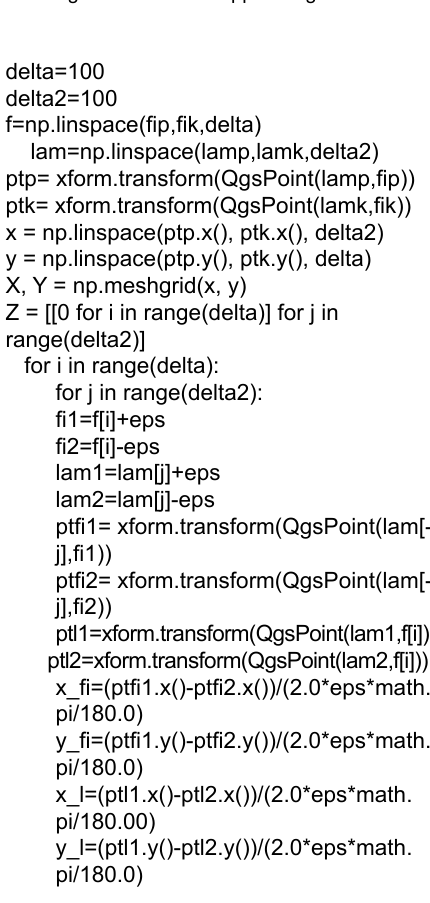
Fig. 15. A map developed in QGIS as a result of using the Indicatrix Mapper